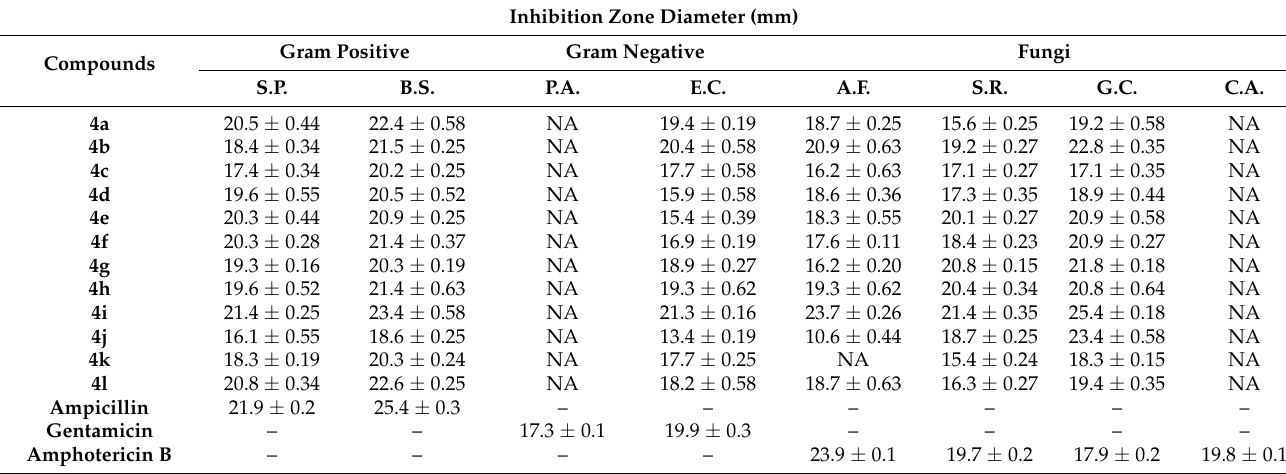
Table 2. Antimicrobial activity of the synthetic compounds (inhibition zone (IZ) diameter (mm)) (1 mg/mL). Inhibition Zone Diameter (mm) Compounds